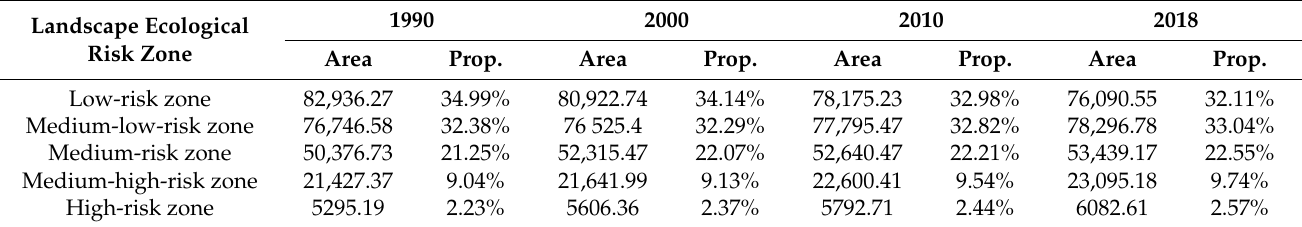
Table 7. Areas (km 2 ) and proportions (“Prop.”) of landscape ecological risk zones in Guangxi during